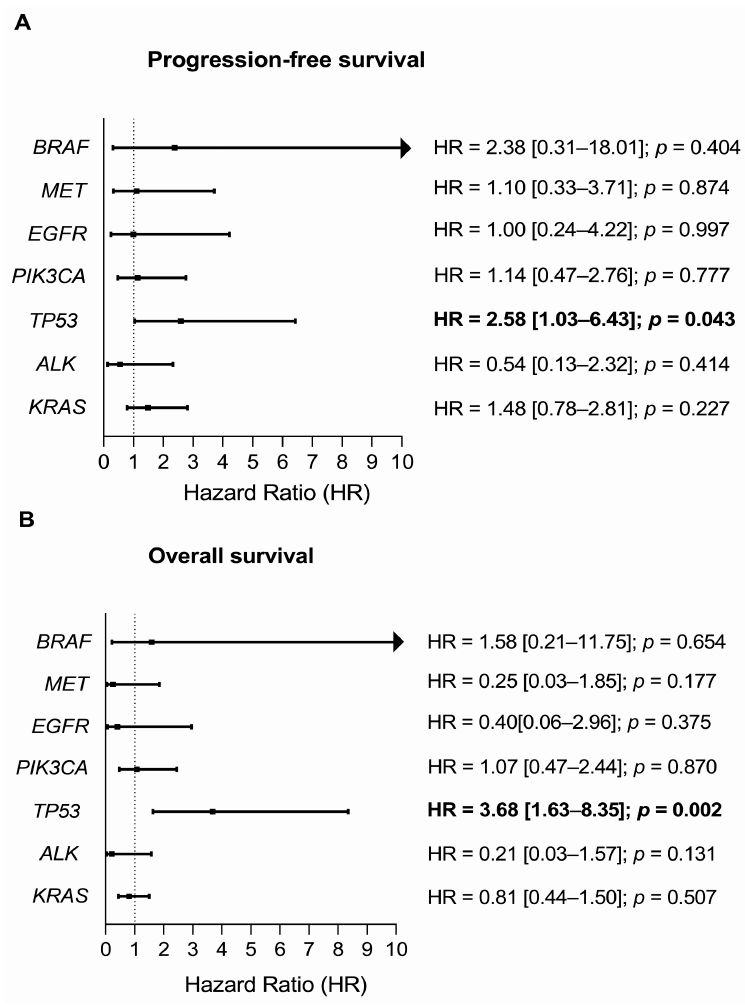
Figure 3. Hazard ratios (HR) [95% confidence interval (CI)] of genes with mutation status for progression-free survival (PFS) and overall survival (OS). ( A ) Progression free survival; ( B ) Overall survival.